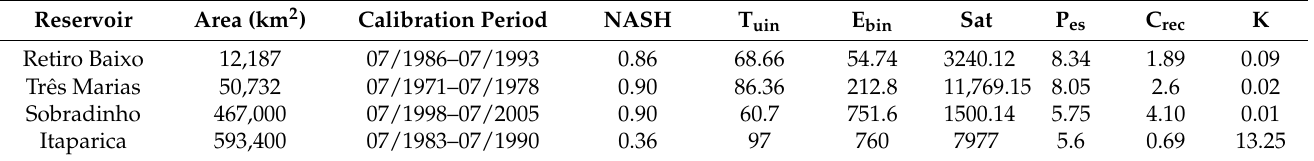
Table 2. Parameters and SMAP calibration for each simulated